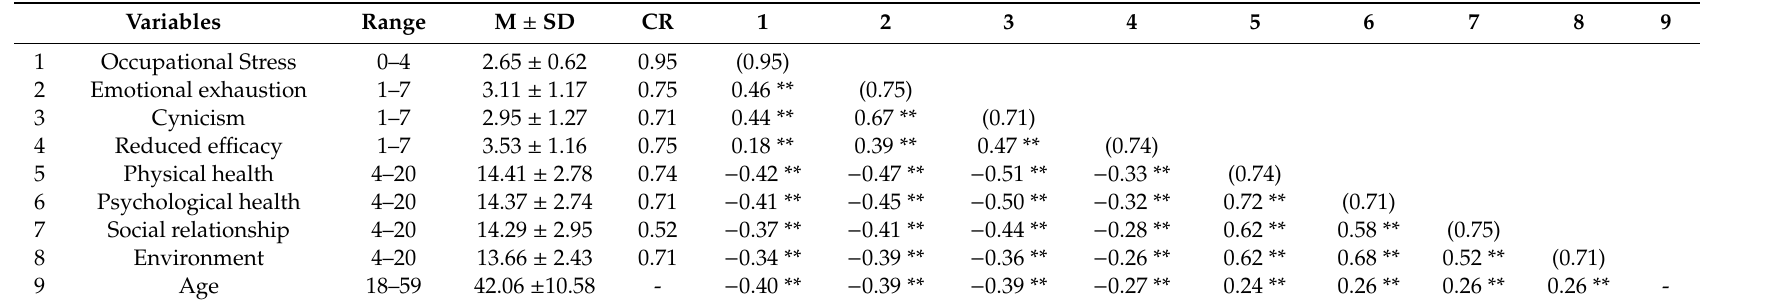
Table 1. Descriptive statistics, internal reliabilities, and correlations among variables ( N =